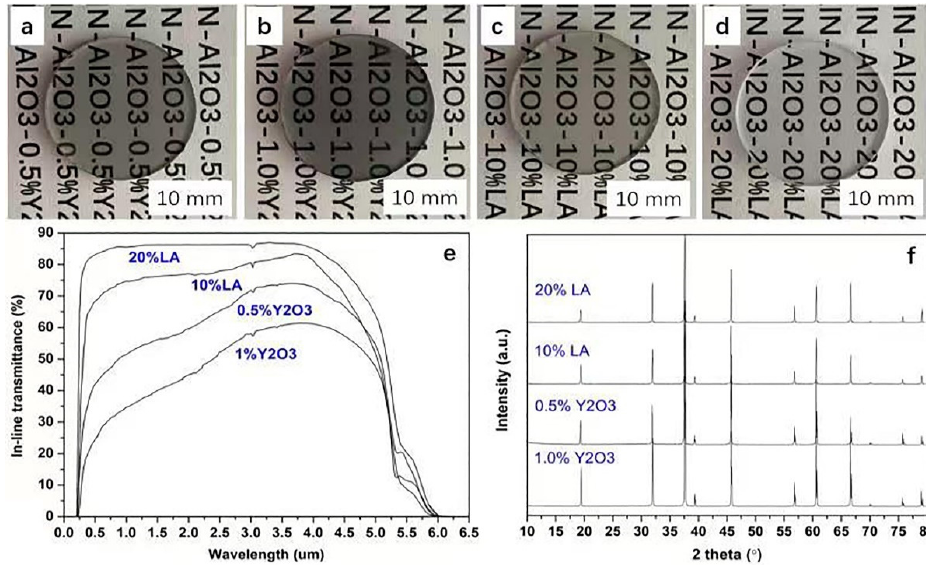
Figure 4. ( a – d ) Photos of the ceramics from AlN–Al 2 O 3 –0.5% Y 2 O 3 , AlN–Al 2 O 3 –1.0% Y 2 O 3 , AlN– Al 2 O 3 –10% LA and AlN–Al 2 O 3 –20% LA, respectively; ( e ) the corresponding transmittance and ( f ) XRD. Table 2. Crystal lattice parameters of the AlON based ceramic samples with different dopants.